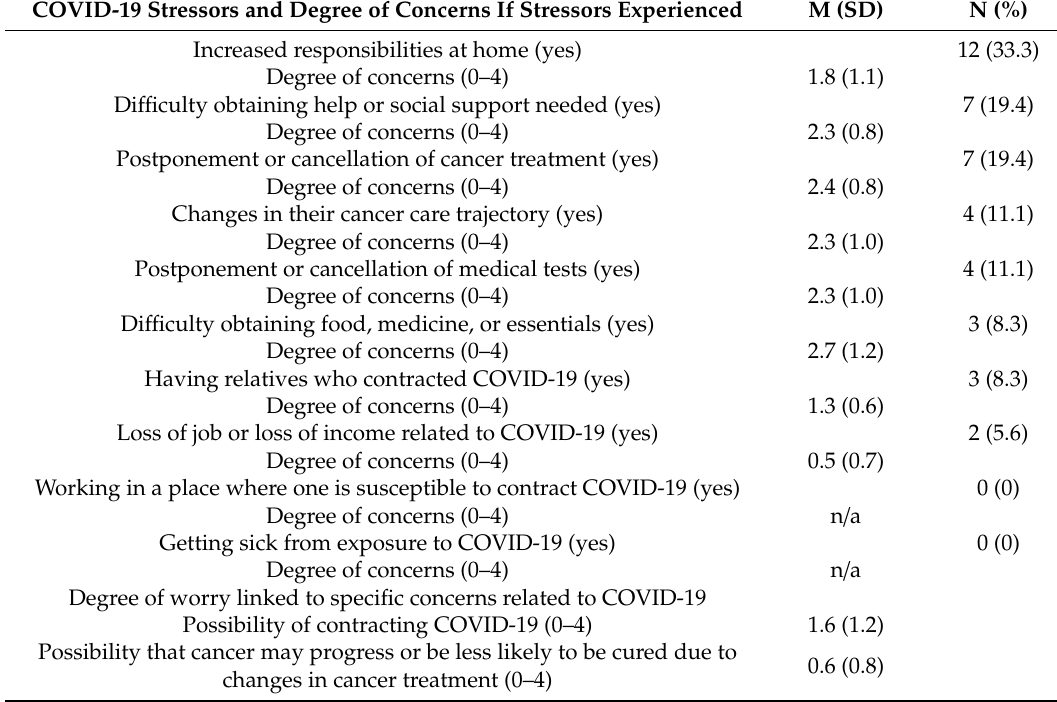
Table 2. Frequencies of COVID-19 stressors and degree of concerns related (N =